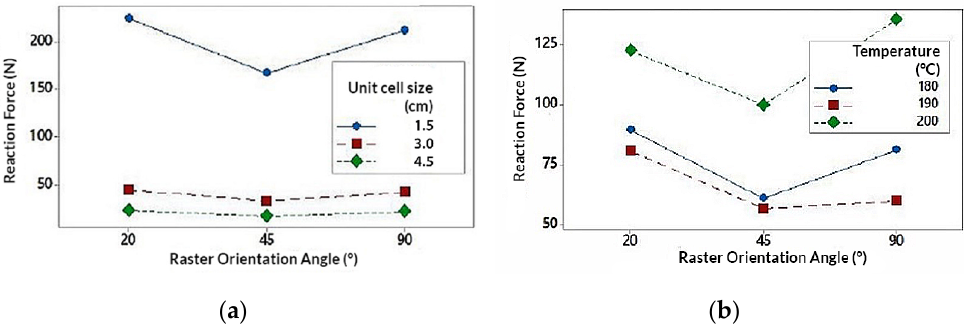
Figure 8. Interaction graph on unit size (U); ( a ) Orientation angle (R) in relation to unit size (U); ( b ) Orientation angle (R) in relation to temperature (T). ( b ) Orientation angle (R) in relation to temperature (T).